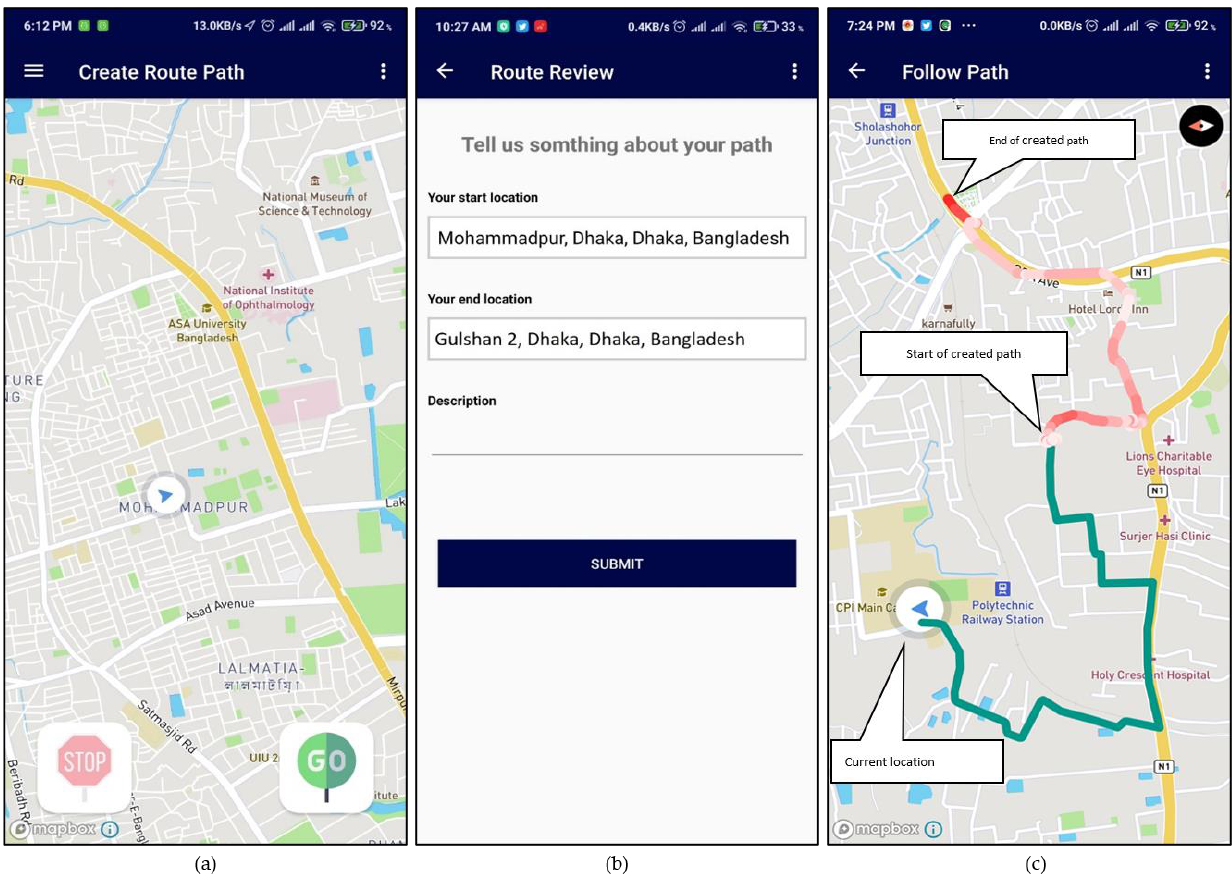
Figure 10. The initial view of ( a ) create a route path, ( b ) after making a path, and ( c ) follow a path option of the mobile application.